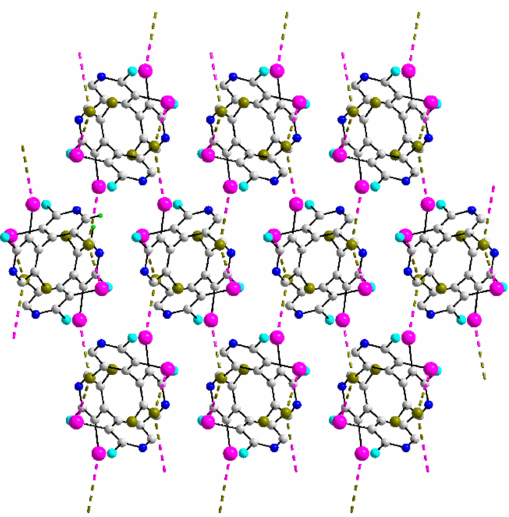
Figure 12. A view of the three-dimensional array in the crystal of 41